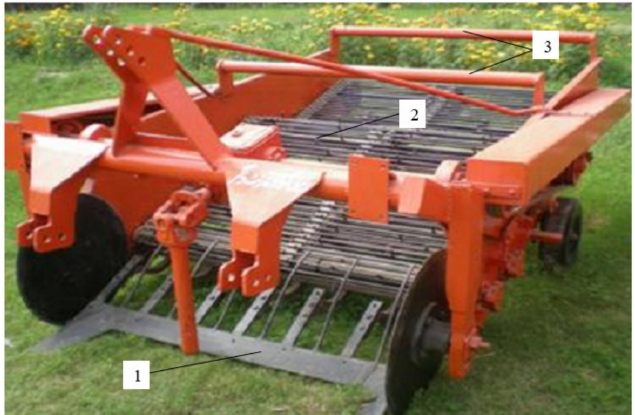
Figure 1. General view of a machine for harvesting root crops: 1, scrounging; 2, separating rod elevator; 3, supporting